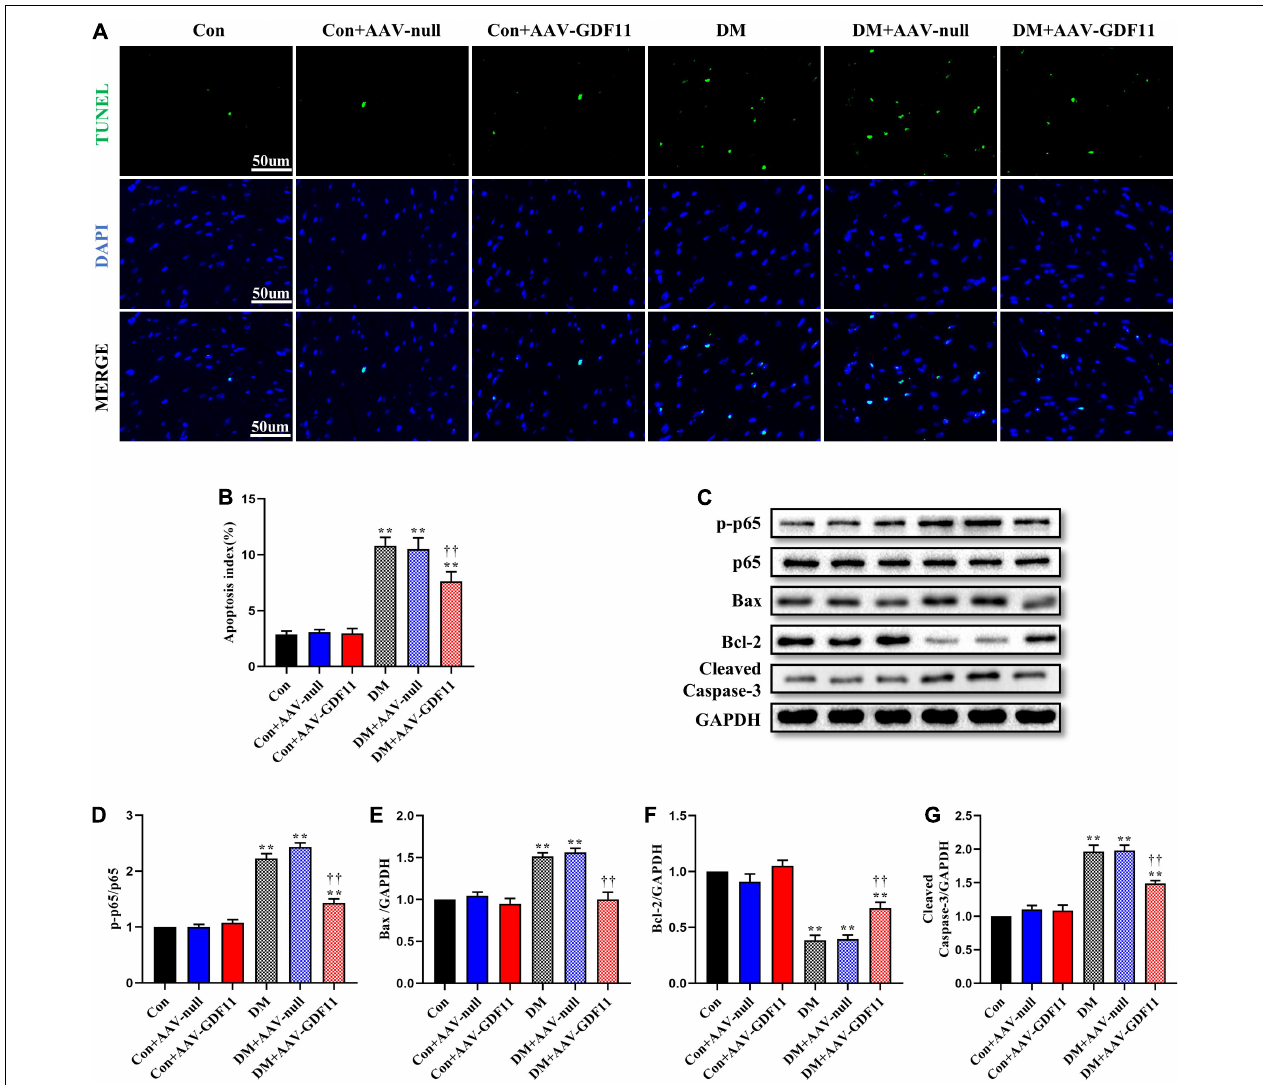
FIGURE 3 | GDF11 prevented diabetes-induced cardiomyocyte apoptosis. (A) Representative images of TUNEL staining (scale bar = 50 µ m). (B) Apoptotic ratio. (C) Representative blots of p-p65, p65, Bax, Bcl-2, and Cleaved Caspase-3. (D) Quantitative analysis of the ratio of p-p65 to p65. (E) Quantitative expression of Bax. (F) Quantitative expression of Bcl-2. (G) Quantitative expression of Cleaved Caspase-3. Data are presented as the mean ± SEM, n = 5 per group. ** P < 0.01 versus the Con group, †† P < 0.01 versus the DM